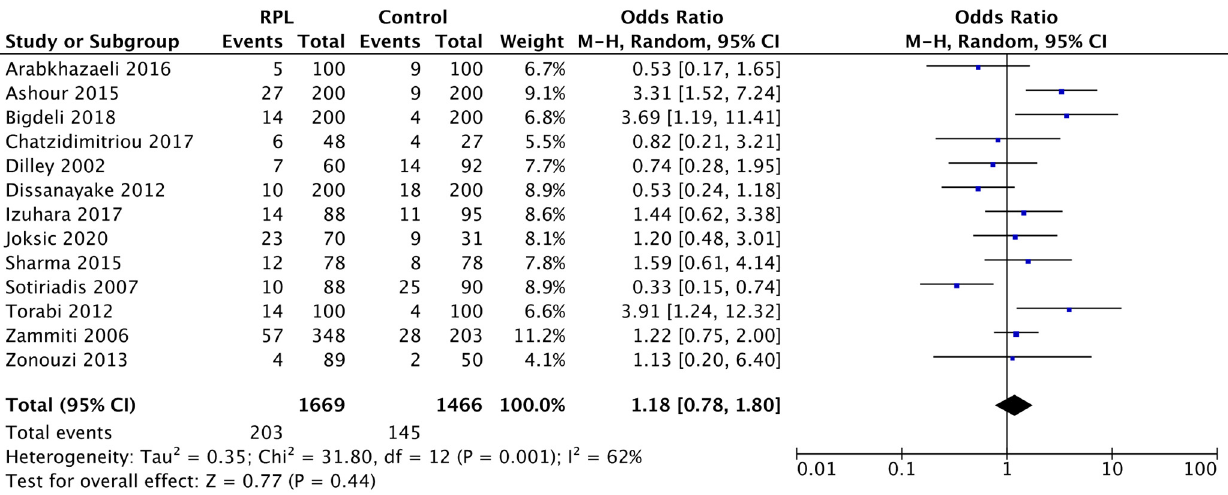
Figure 3. Forest plot of the association between H1299R and RPL. Squares display the effect estimate (ORs) with the size of each blue square corresponding to the weight given to each study in the meta-analysis. Horizontal lines represent the 95% CIs corresponding to each effect estimate. The black diamond represents the overall effect of intervention with its width representing the overall 95% CI. The I 2 statistic represents a measure of heterogeneity. Overall effect OR: 1.18 [0.78, 1.80]; p = 0.44.